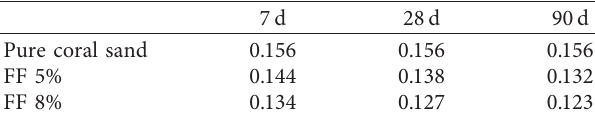
Figure 5: Free chloride content reduction rate in FS and SS systems. Table 8: Free chloride content in fresh water